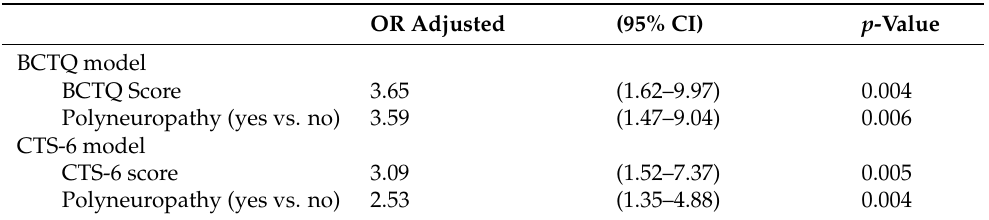
Table 3. Multiple logistic regression having CTS dependent variable predicted according to the Boston carpal tunnel questionnaire and the six-item CTS symptoms scale and diabetic